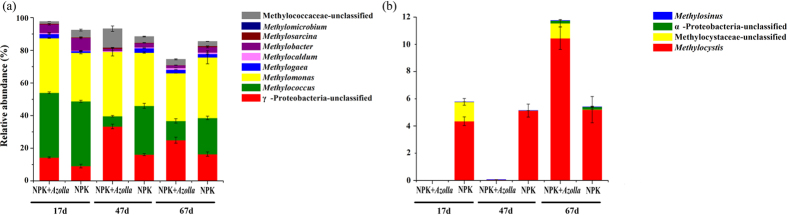
Variations in the communities of Type I methanotrophs (a) and Type II methanotrophs (b) in the paddy soil during the rice cultivation period. Methanotrophic bacterial pmoA gene sequencing reads were classified at the genus level using the RDP Classifier (http://rdp.cme.msu.edu/) against the FGR functional gene database; only the genera known as methanotrophs were shown. NPK, rice cropping without dual cropping of Azolla under recommended fertilization; NPK + Azolla, rice cropping with dual cropping of Azolla under recommended fertilization.